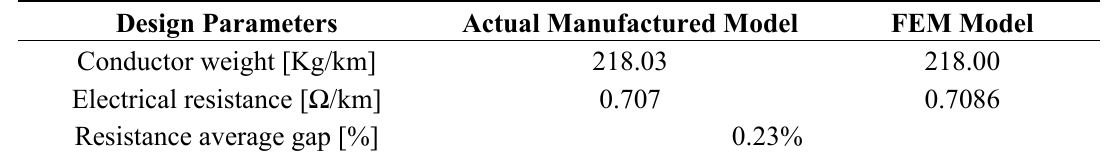
Table 2. Main results of actual and FEM models electrical resistance and conductor weight